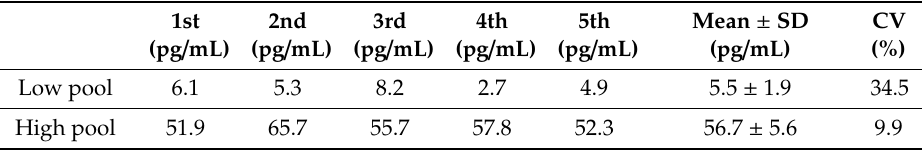
Table 1. Results of the five intra-assay repetitions of the “low pool” and the “high pool”, prepared by mixing the 6 samples with the lowest bigET-1 concentration and the 6 samples with the highest bigET-1 concentration.